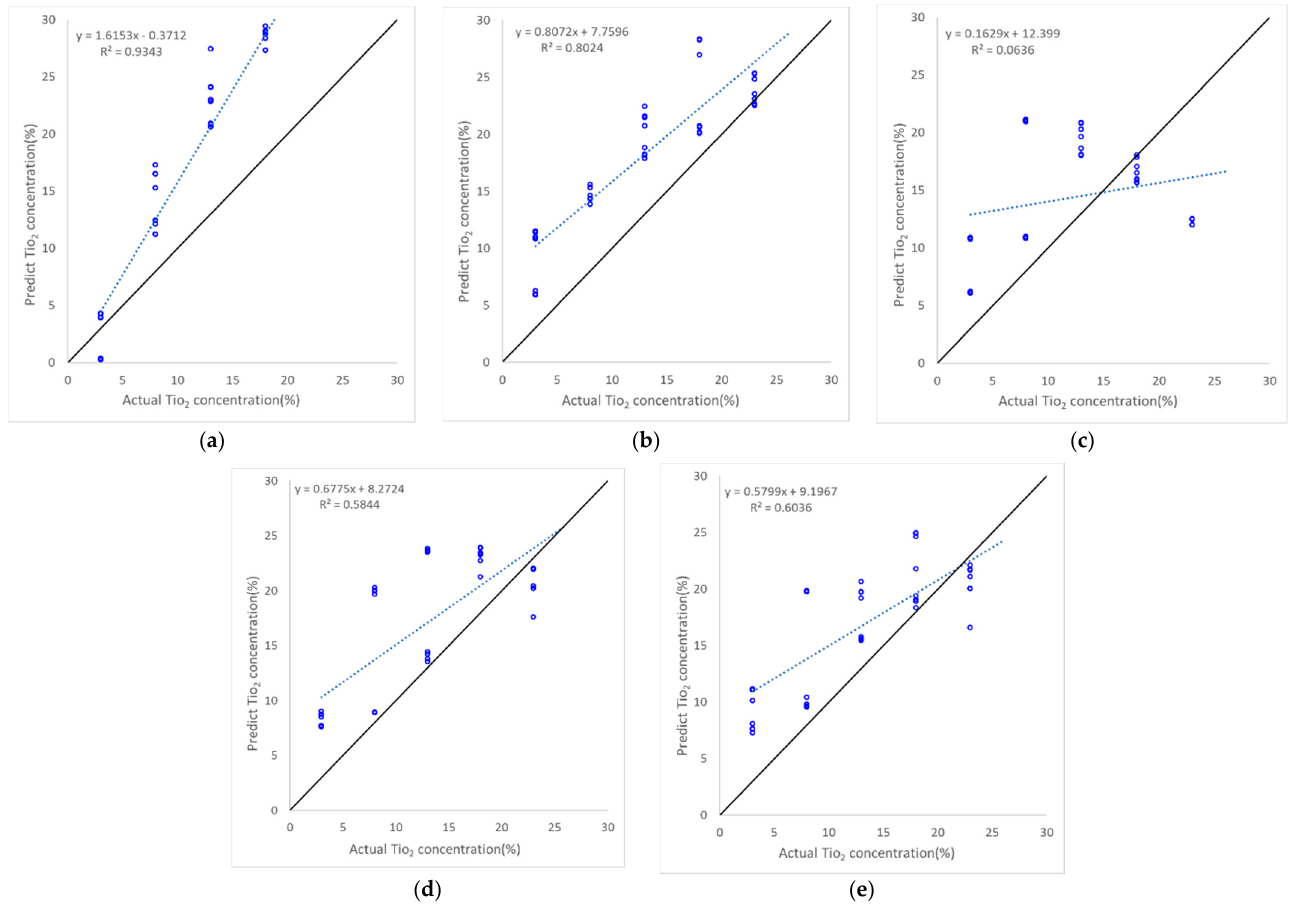
Figure 14. Scatter plots of the TiO 2 estimation performance for Dataset II of the five machine learning algorithms; ( a ) Ridge regression; ( b ) Lasso regression; ( c ) Support vector regressor; ( d ) Random Forest Ensemble; ( e ) XGBoost. The 1:1 line is in black, and the blue dashed line represents the regression line fitted to actual and predicted TiO 2 concentrations.